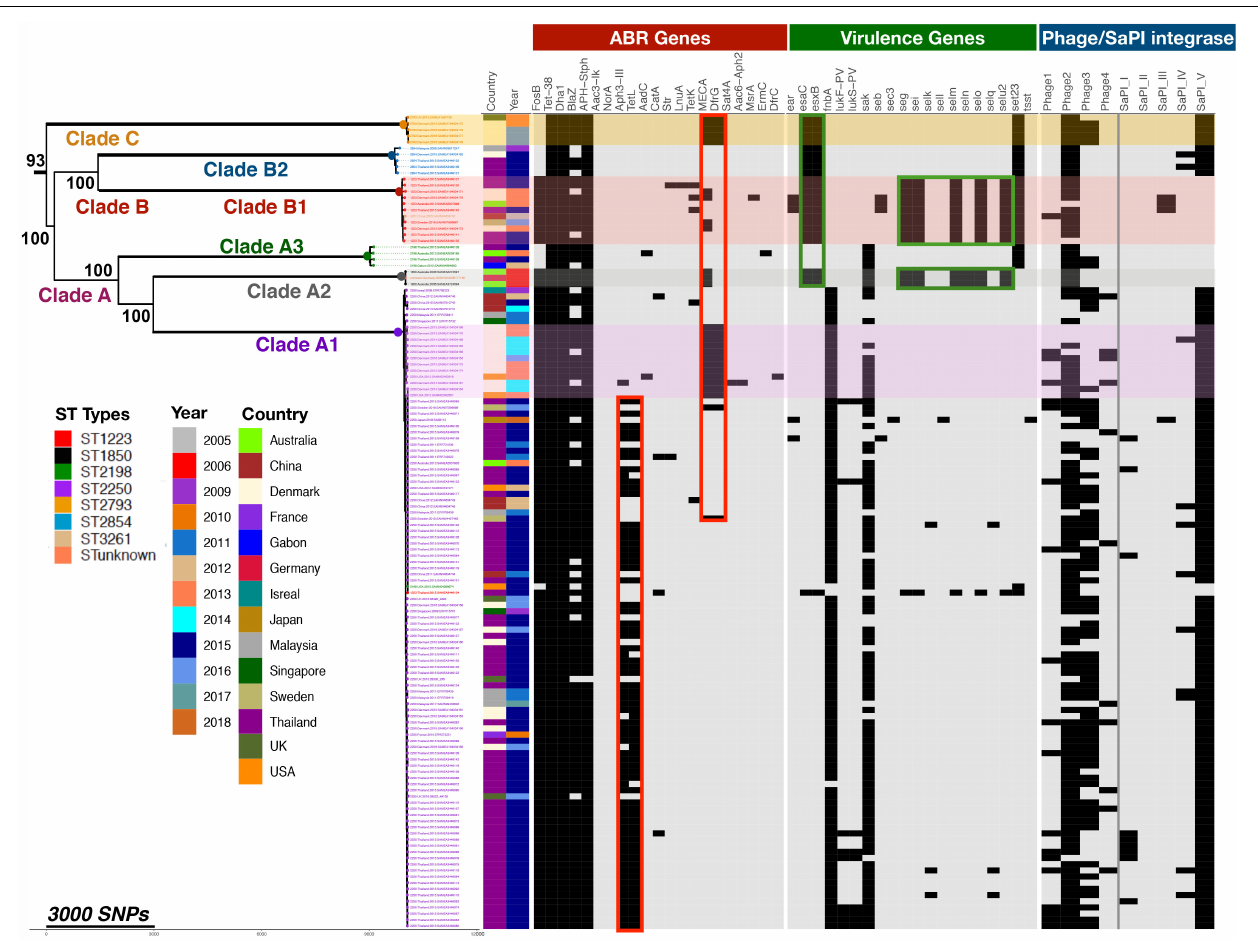
FIGURE 2 | Phylogenetic relationship of global S. argenteus strains related to content of antibiotic resistance genes, virulence determinants, and phages. The phylogenetic tree shows relationships between the strains based on core gene SNPs. Different clades, the ST, year of isolation and country of origin are as shown. The presence of antibiotic resistance determinants, selected virulence genes, and phage integrases with SaPI island integrase present in STs are indicated to the right of the tree; presence of these factors is indicated by a black rectangle. Boxed areas highlight specific ABR (red) or virulence genes (green). Bootstrap support for the major clades is shown from 1,000 bootstrap trees. The scale bar shows the number of SNPs corresponding to branch